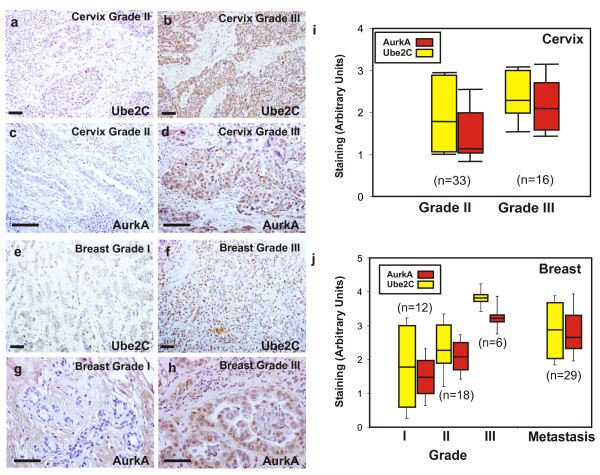
UBE2C and AURKA expression in human breast and cervical carcinoma samples. Representative examples of UBE2C (a, b, e and f) and AURKA (c, d, g and h) expression patterns in cervical (a, b, c and d) and breast carcinoma (e, f, g and h) primary tumors of different grades. Box plots of relative quantitation in primary cervical (i) and breast (j) tumors of different grades and breast metastases to lymph nodes (j) are represented.